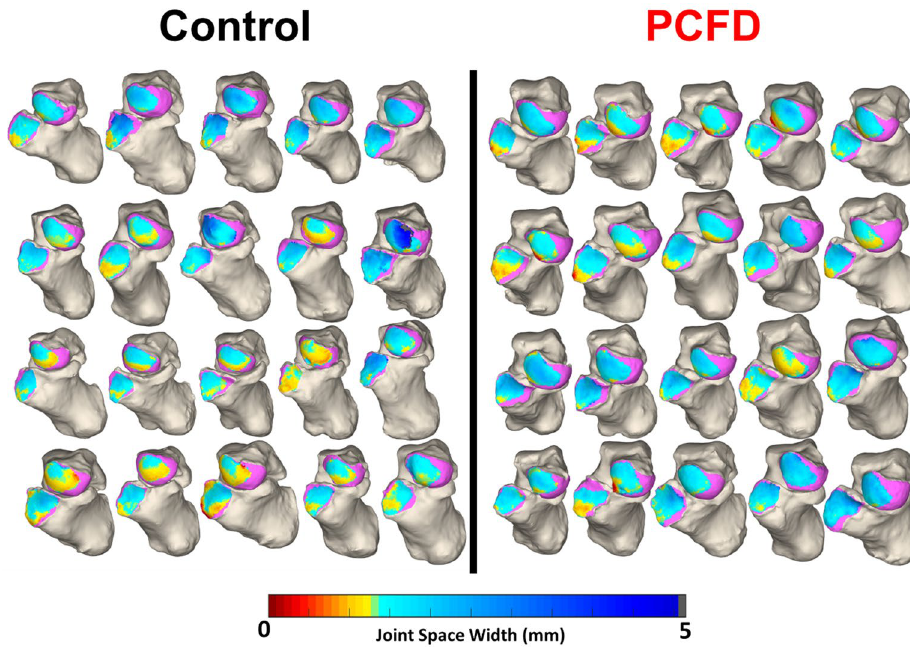
Figure 7. Chopart joint distance maps for all control and Progressive Collapsing Foot Deformity feet. The navicular and cuboid are removed to show an anterior view of the talar head and calcaneocuboid facet. Normal joint distances are shown in blue while distances over 5 mm are identified in gray and under 1.5 mm in green to yellow and under 1 mm in orange and red.